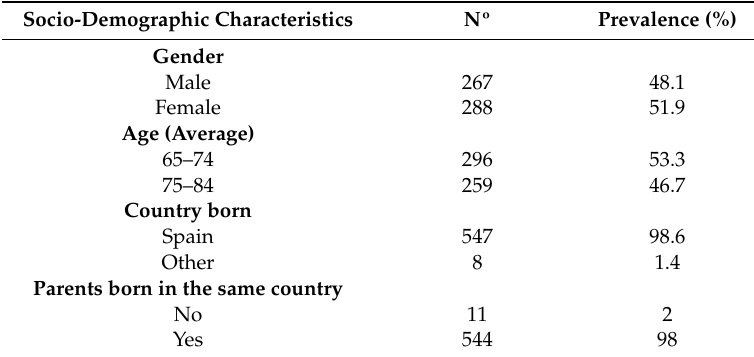
Table 1. Sociodemographic characteristics of the sample ( N =